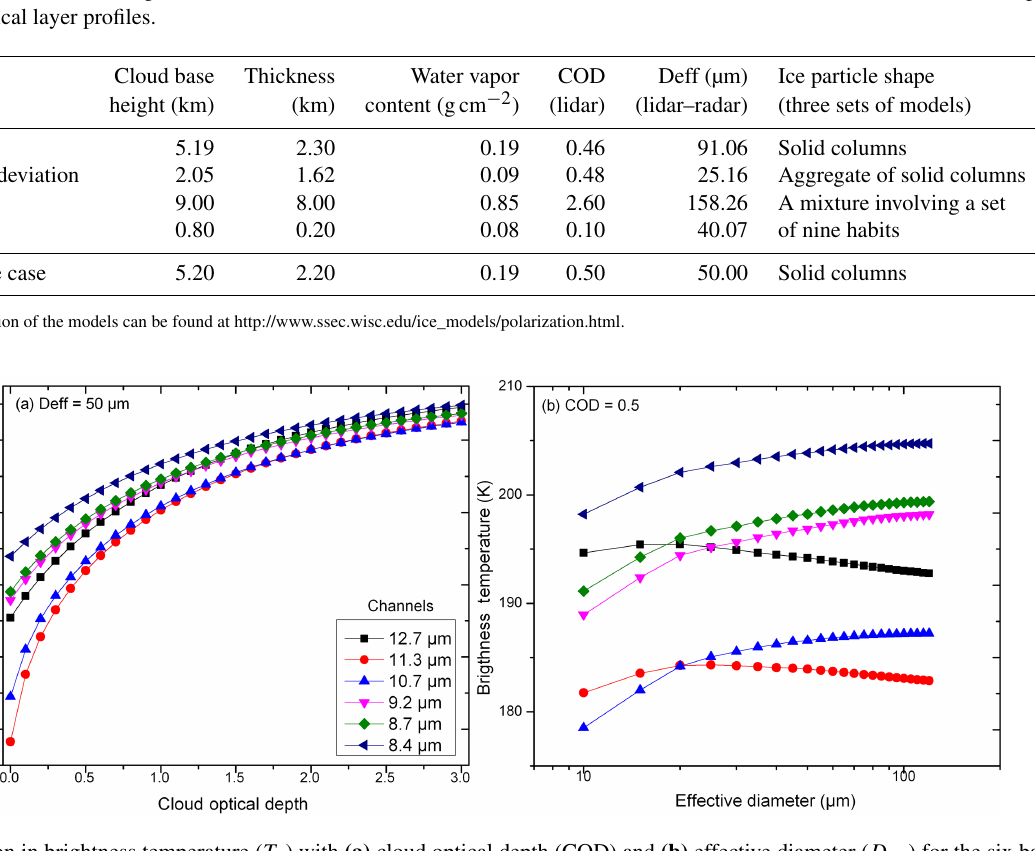
Figure 3. Variation in brightness temperature ( T b ) with (a) cloud optical depth (COD) and (b) effective diameter ( D eff ) for the six bands of the CIMEL CE-312. The color legend of the left graph applies to both graphs. The MODTRAN input parameters for this reference case are detailed in Table